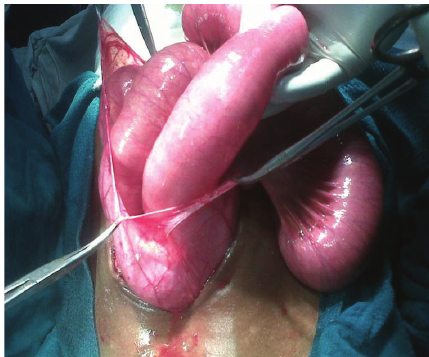
Figure 1: Entire small gut in the left paraduodenal area enclosed in a hernia sac.